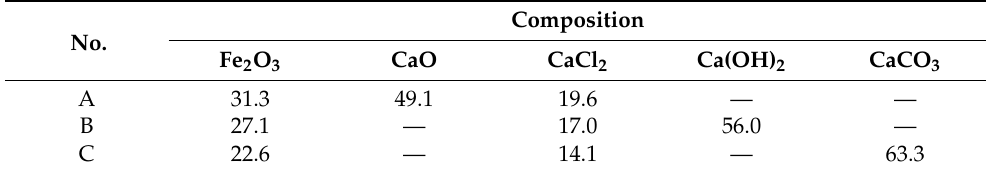
Table 2. Chemical composition of the dephosphorizer